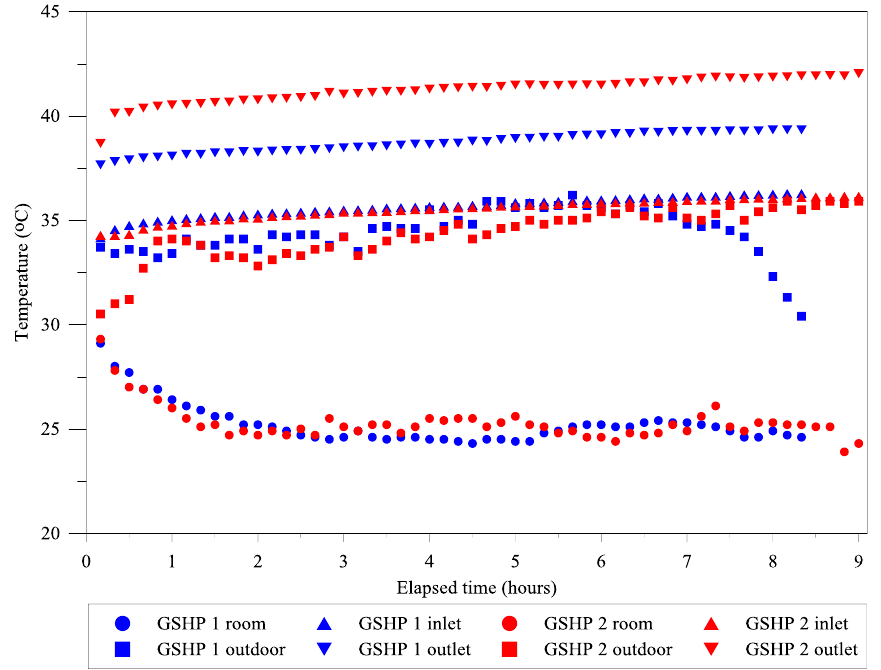
Figure 15. Temperature data of GSHP 1 (May 20) and GSHP 2 (May 9). Energies 2019 , 12 , x FOR PEER REVIEW